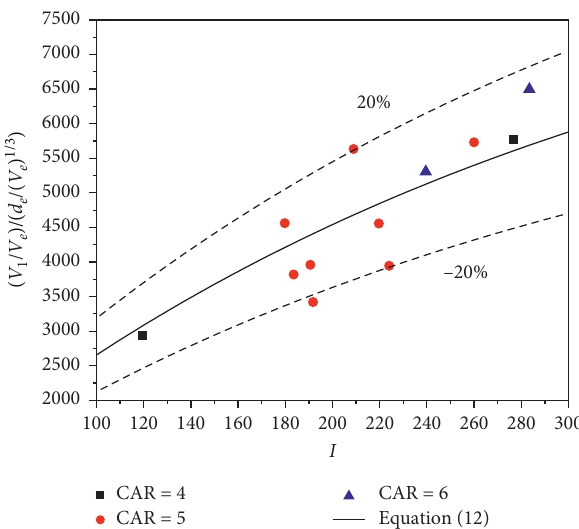
Fragment formation